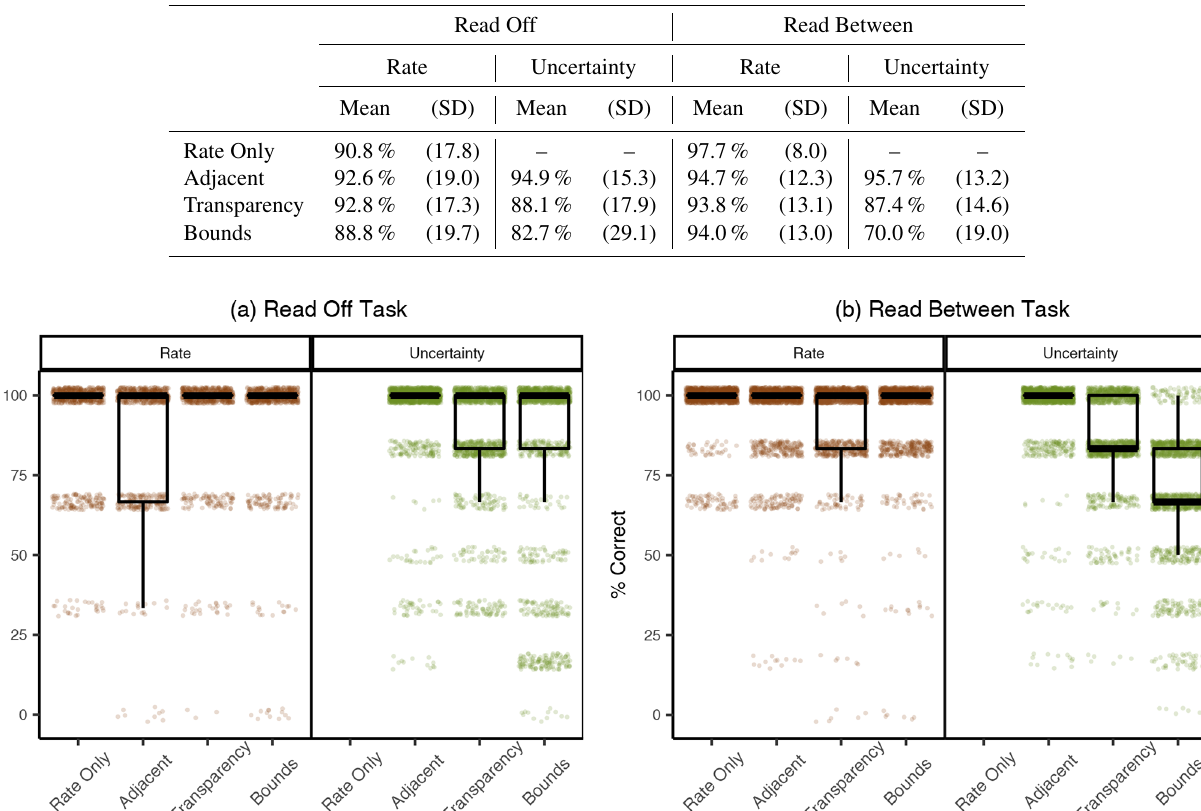
Table 3. Percentage of trials answered correctly by condition for both map-reading tasks, separately for rate and uncertainty levels. Partici- pants in the Rate Only condition were not asked to read uncertainty in either task.